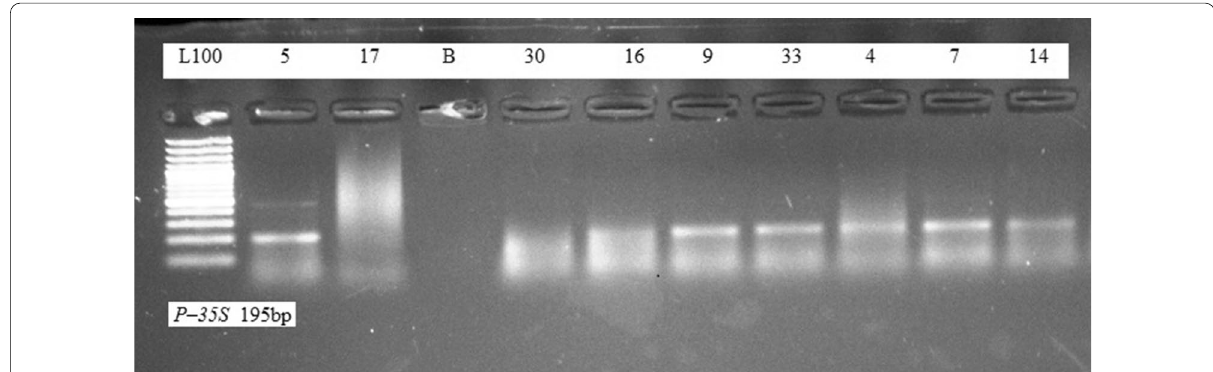
Fig. 1 Selected PCR amplification products of P ‑ 35S (195 bp) in some of the collected plant and animal feed samples . B is blank